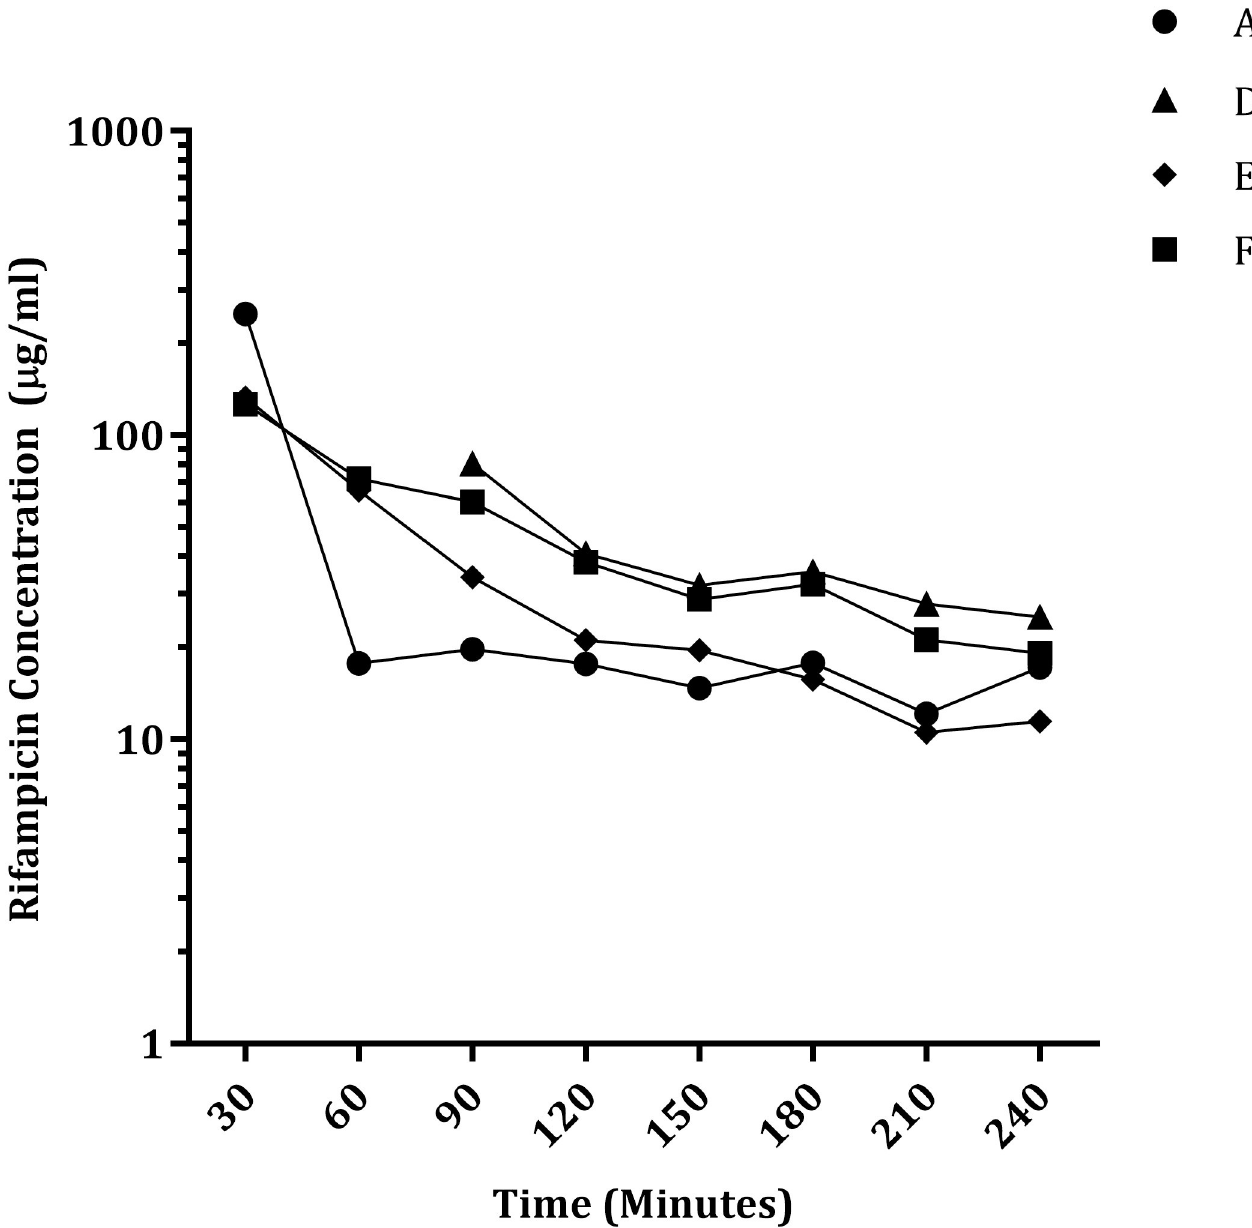
Fig 2. Rifampicin concentrations recovered from sacrospinalis. Fractions were collected over a four-hour (240 minute) period from four guinea pigs every 30 minutes. The measured rifampicin concentrations in each fraction are shown.